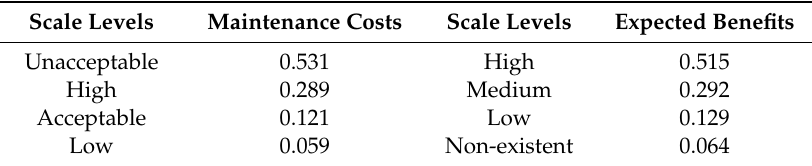
Table 16. Weightings of the scale levels of the descriptors of